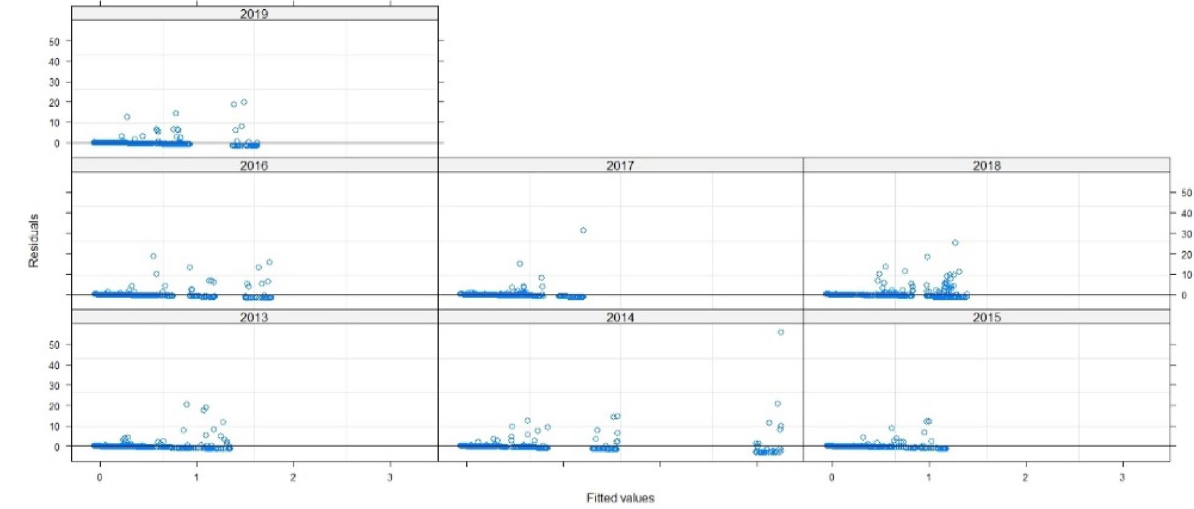
Figure 12. Errors in terms of the adjusted values.